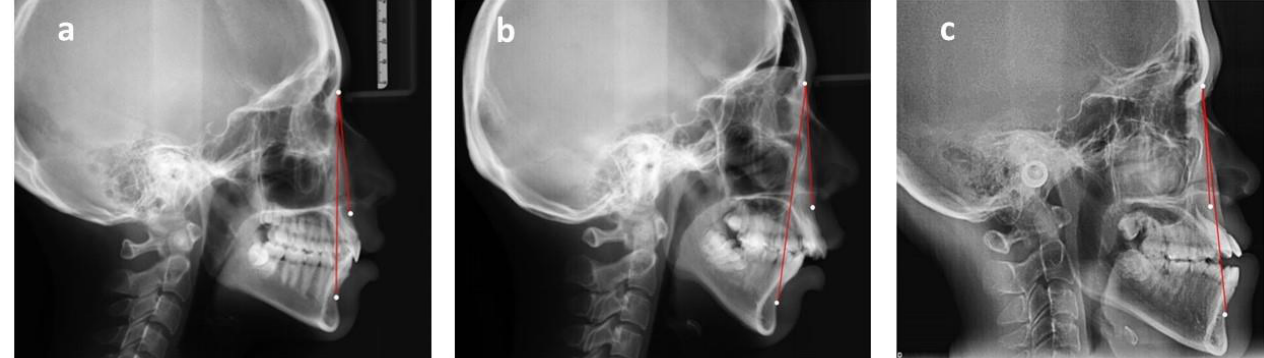
Figure 2. Sagittal skeletal classification based on ANB angle. ANB: The angle is constructed by connecting the A point, nasion, and B point. According to the Steiner analysis, the measurement represents the skeletal relationship between the maxilla and mandible. ( a ) Class I relationship: ANB is between 2 and 4. ( b ) Class II relationship: ANB is greater than 4. ( c ) Class III relationship: ANB is below 2 or negative.